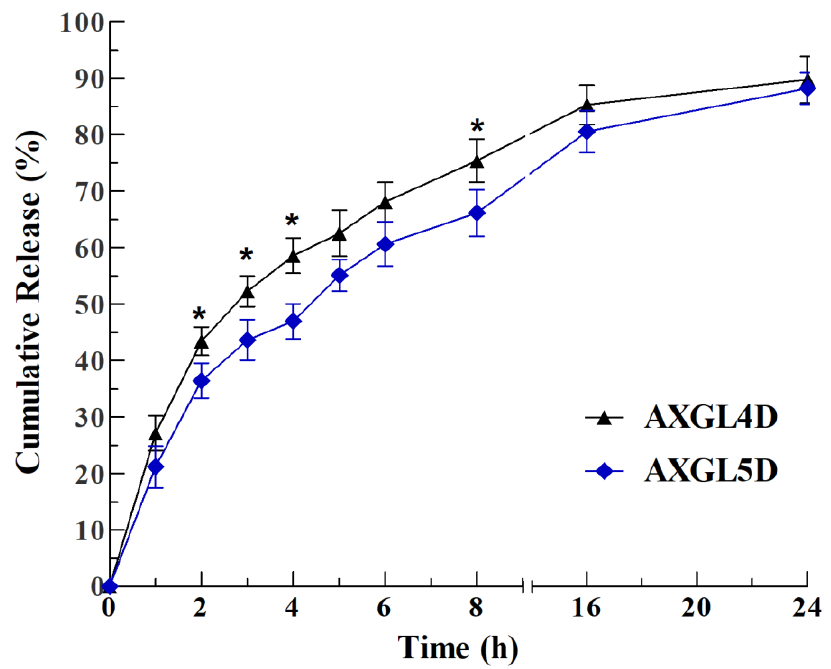
Figure 5. Gentamicin release profile from AX-GL films. The asterisks (*) represent a significant difference (* p < 0.05) of AXGL4D from AXGL5D. Table 3. Mathematical modeling of antibiotic release from AX-GL